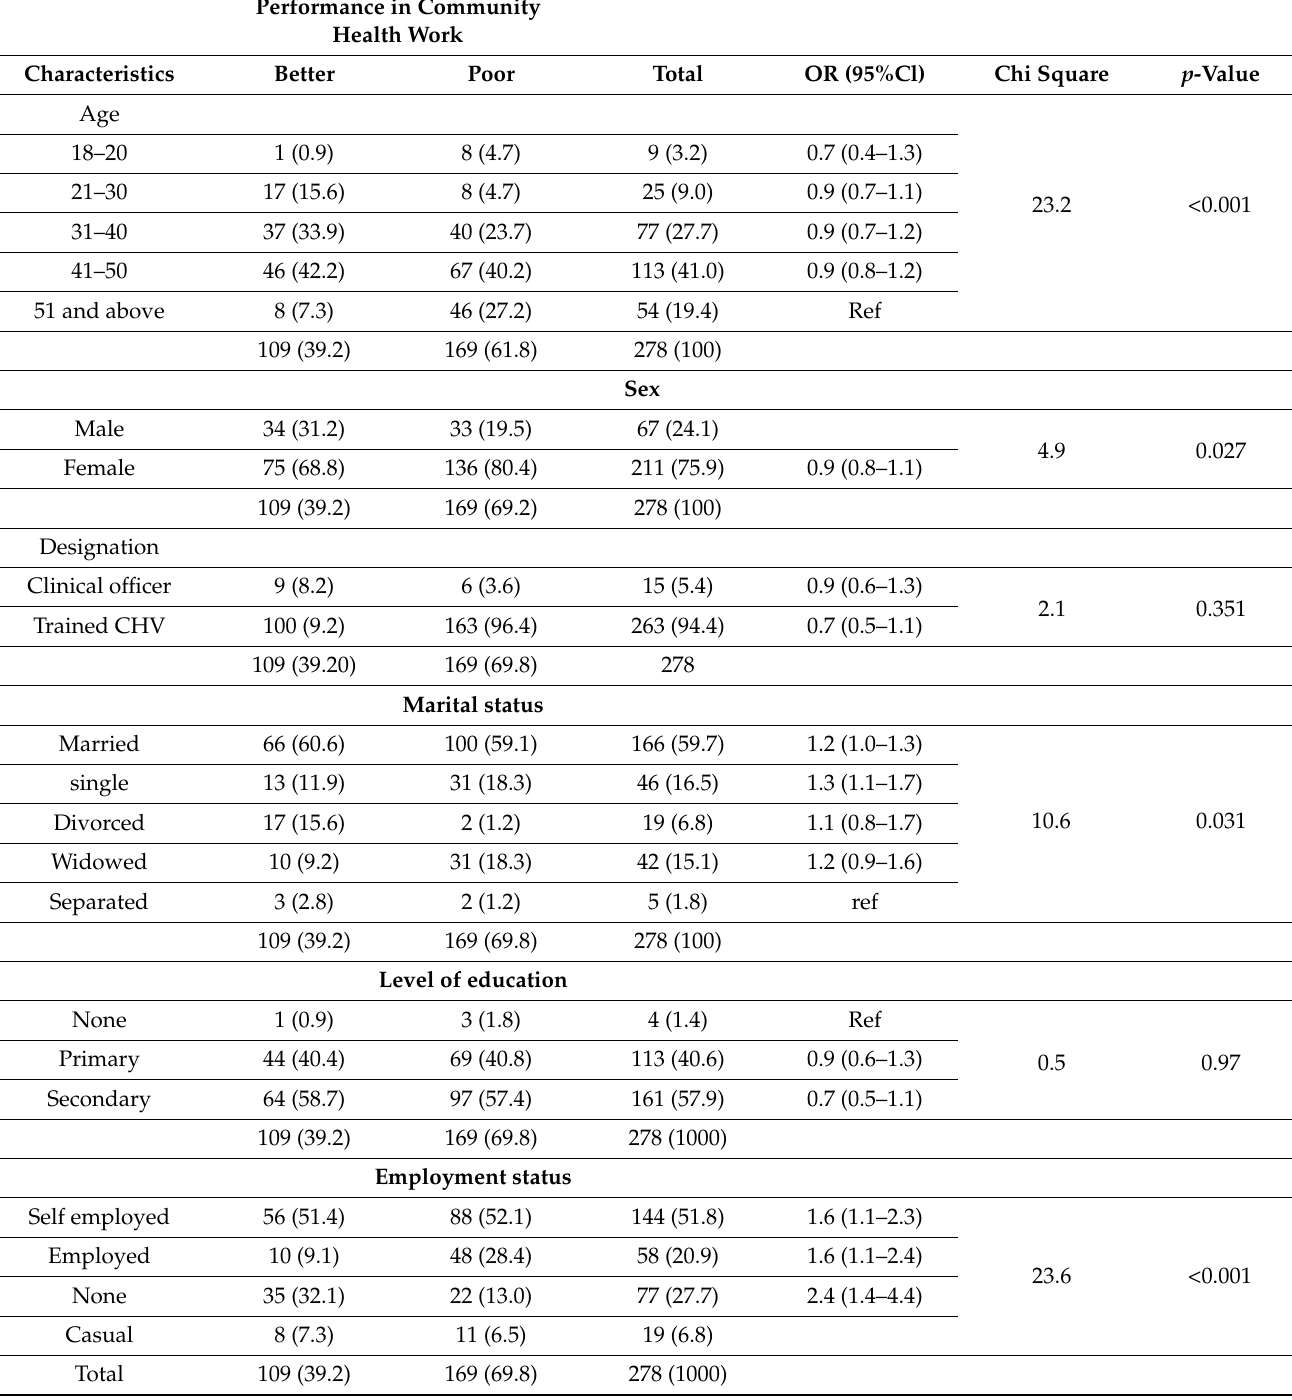
Table 2. Demographics characteristics and performance of community health workers. Performance in